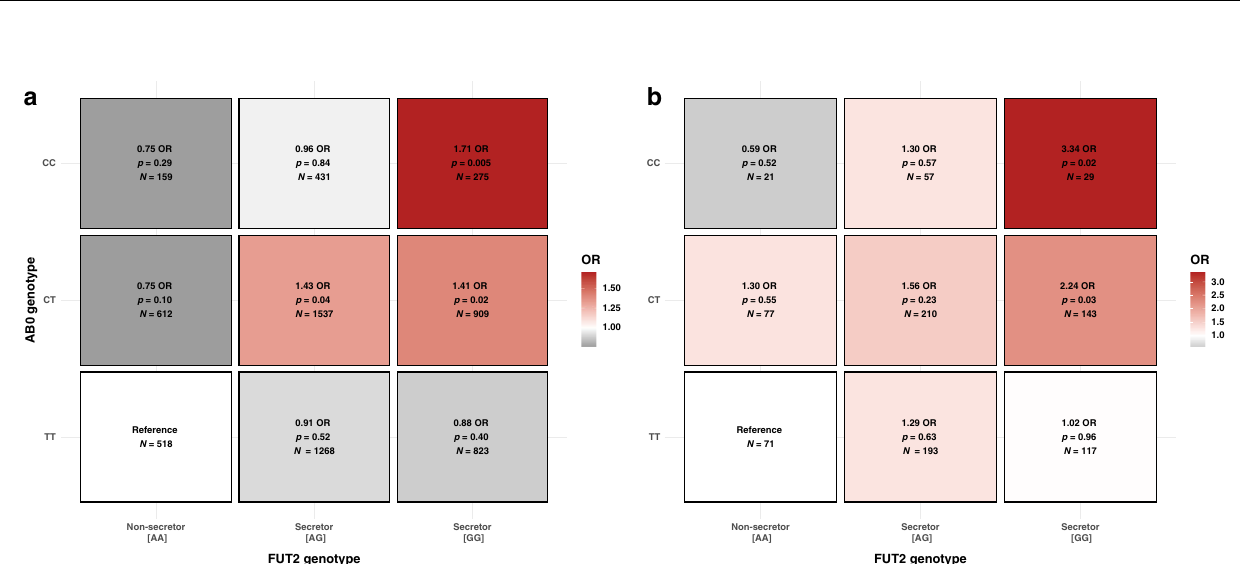
(Table 3 and Fig. 4) and with current asthma by age 6 years (OR = 4.71 (95% CI = 1.73 – 13.07), P = 0.003), but not with lung function or other asthma-related traits (Supplementary Table 12).